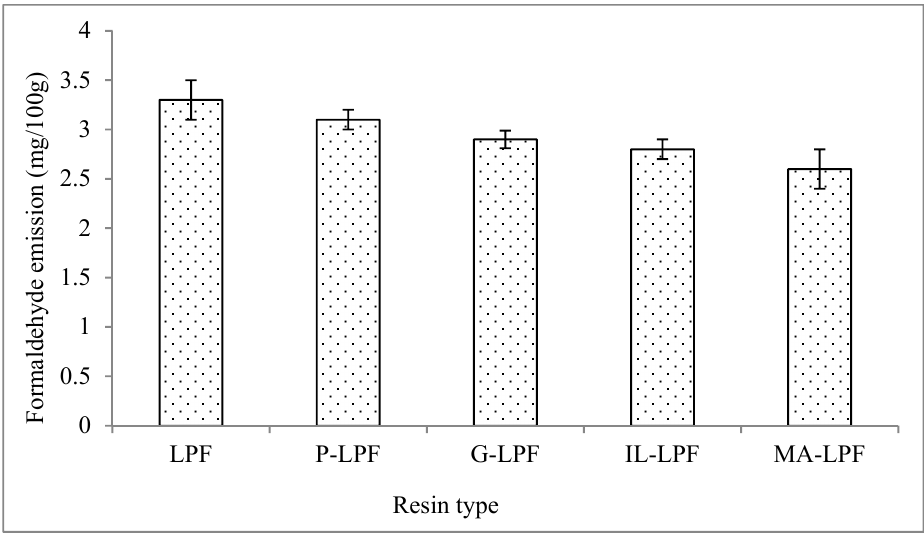
the lowest water absorption (41%) and thickness swelling (16%), while the unmodified 227